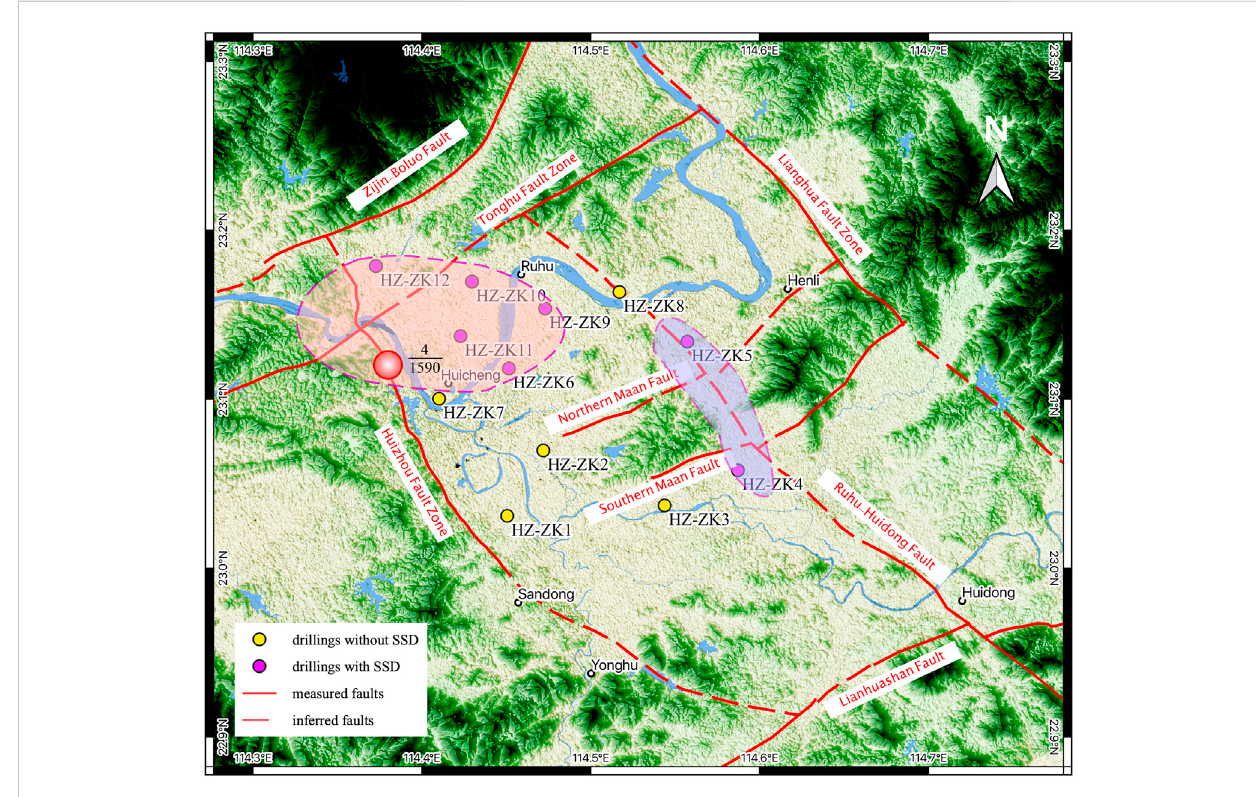
HZB. The results indicate that mottle clay is an admixture of aeolian yellow silt and underlying fl uvial sands, originating from liquefaction-induced SSDS during the late Pleistocene. After considering possible trigger agents, tectonic activity was considered to have trigger liquefaction and SSDS, which is supported by the close spatial relationship between mottled clay and regional faults. The SSDS of mottled clay could be a potential indicator of paleo-earthquakes in the coastal region of the northern South China